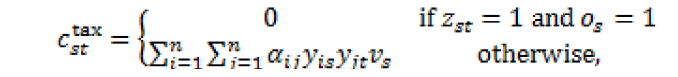
Figure 5. An example illustrating Φ